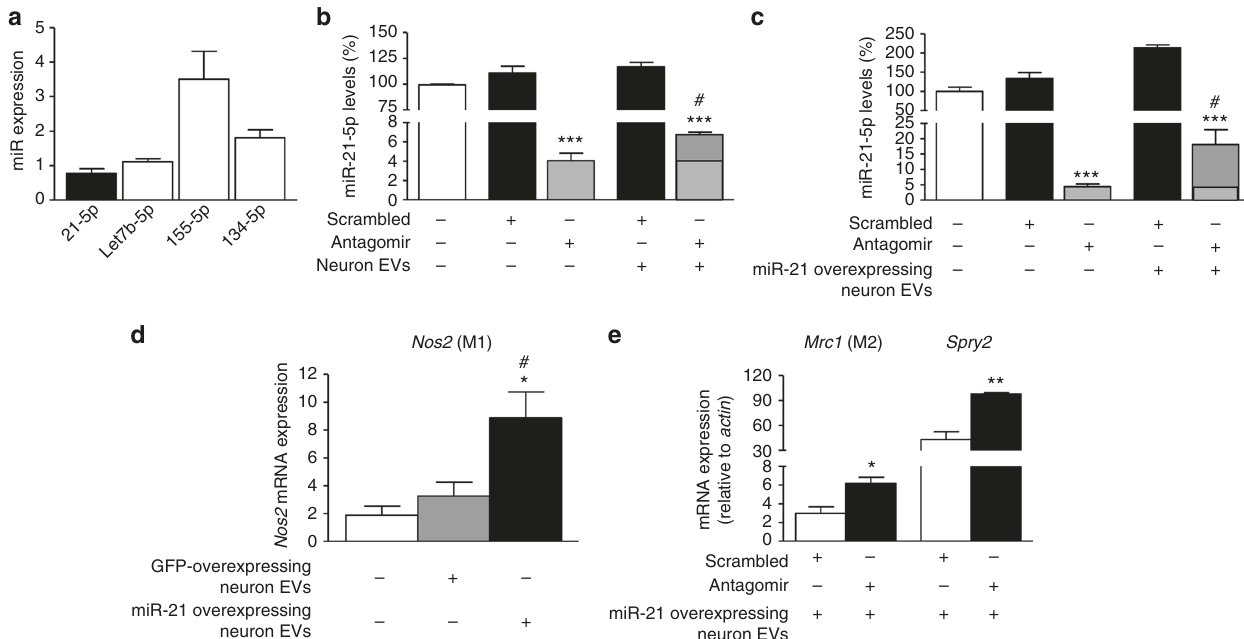
Fig. 5 Expression of miR-21-5p is increased in antagomir-transfected macrophages exposed to capsaicin-released exosomes. a Peritoneal macrophage intracellular expression of miRs 21-5p, Let7b-5p, 155-5p, and 134-5p normalized to SNORD 202 (housekeeping non-coding RNA; n = 4 cultures). b miR-21- 5p expression in macrophages transfected with miR-21-5p antagomir or scrambled oligomer and incubated with or without EVs derived from CAPS-treated pure DRG neurons. c miR-21-5p expression in macrophages transfected with miR-21-5p antagomir or scrambled oligomer and incubated with or without miR-21-overexpressing EVs derived from CAPS-treated DRG neurons. Data are means ± S.E.M., n = 3; *** P < 0.001, compared to scrambled oligomer; # P < 0.05, compared to macrophages not exposed to EVs, one-way ANOVA, post hoc Bonferroni test. d Expression of Nos2 mRNA in macrophages incubated with GFP-overexpressing or miR-21-overexpressing neuronal EVs. Data are means ± S.E.M., n = 3; * P < 0.05 compared to macrophages not exposed to EVs; # P < 0.05 compared to GFP-derived EVs, one-way ANOVA, post hoc Bonferroni test. e Mrc1 and Spry2 mRNA expression levels in macrophages transfected with miR-21-5p antagomir or scrambled oligomer and incubated with miR-21-overexpressing EVs derived from CAPS-treated DRG neurons. Data are means ± S.E.M., n = 3; * P < 0.05 and ** P < 0.01 Student ’ s t